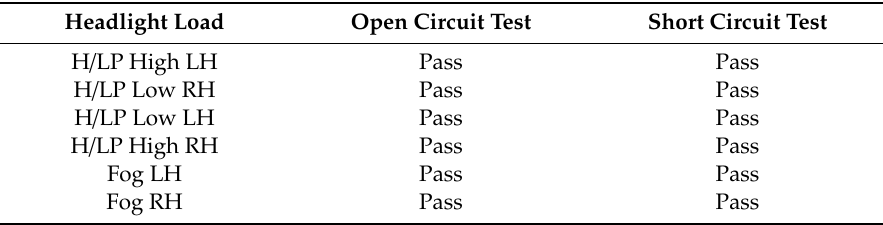
Table 5. Results of protective operation